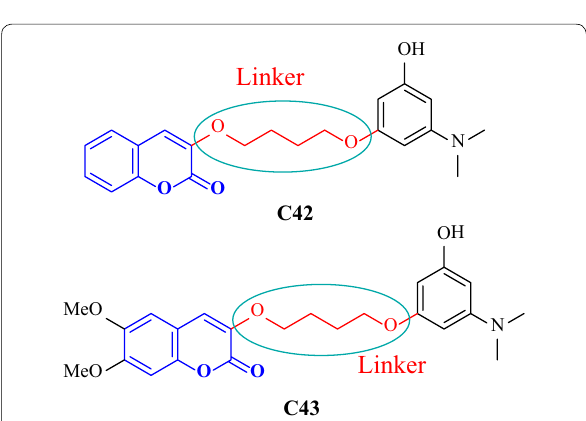
Fig. 42 Molecular structures of dimethylamino coumarin derivatives C42 and C43